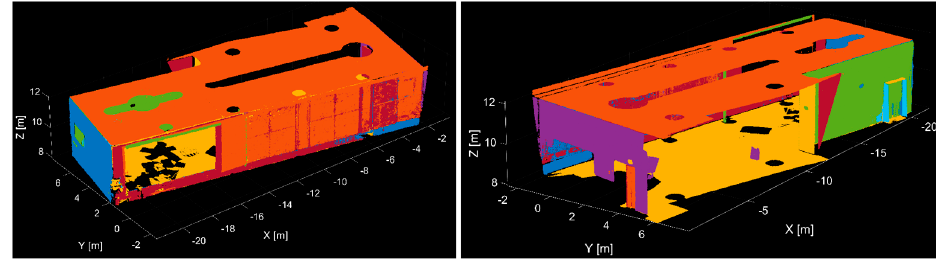
Figure 8. Result of the plane segmentation.